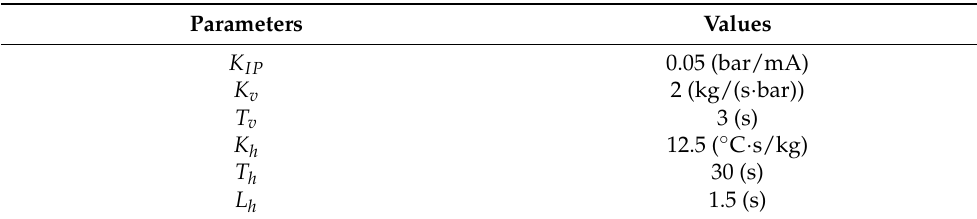
Table 1. Parameters of each element in the regasification